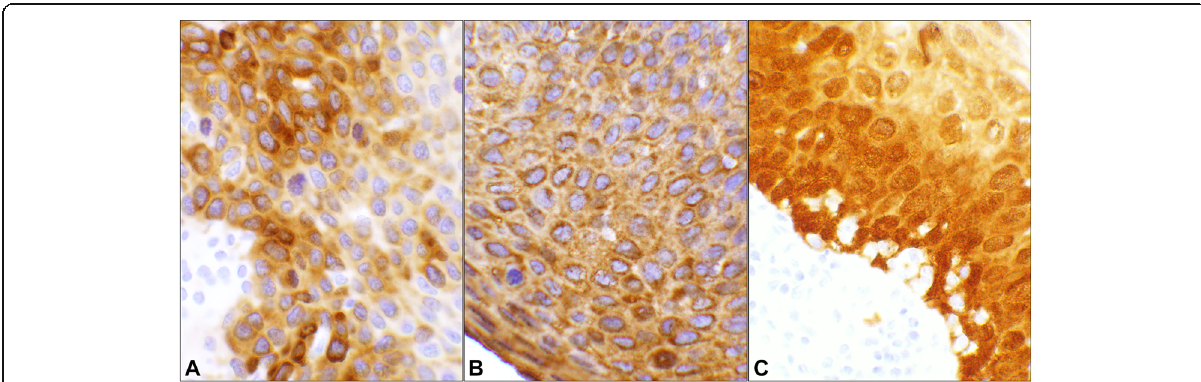
Fig. 1 Immunohistochemical (IHC) reactivity pattern of the three markers. The three photomicrographs are obtained from a case of High grade squamous intraepithelial lesion (HSIL) (Case# 22, Supplemental Table 1). A Stathmin-1 shows the perinuclear cytoplasmic staining involving more than two third of the epithelial thickness. B HSP27 immunohistochemistry shows cytoplasmic staining of the dysplastic squamous cells covering the full thickness of the epithelium. C p16 positive immunostain of the entire epithelium which involves both nucleus and cytoplasm, but more intensely depicting the nuclei. (Objective